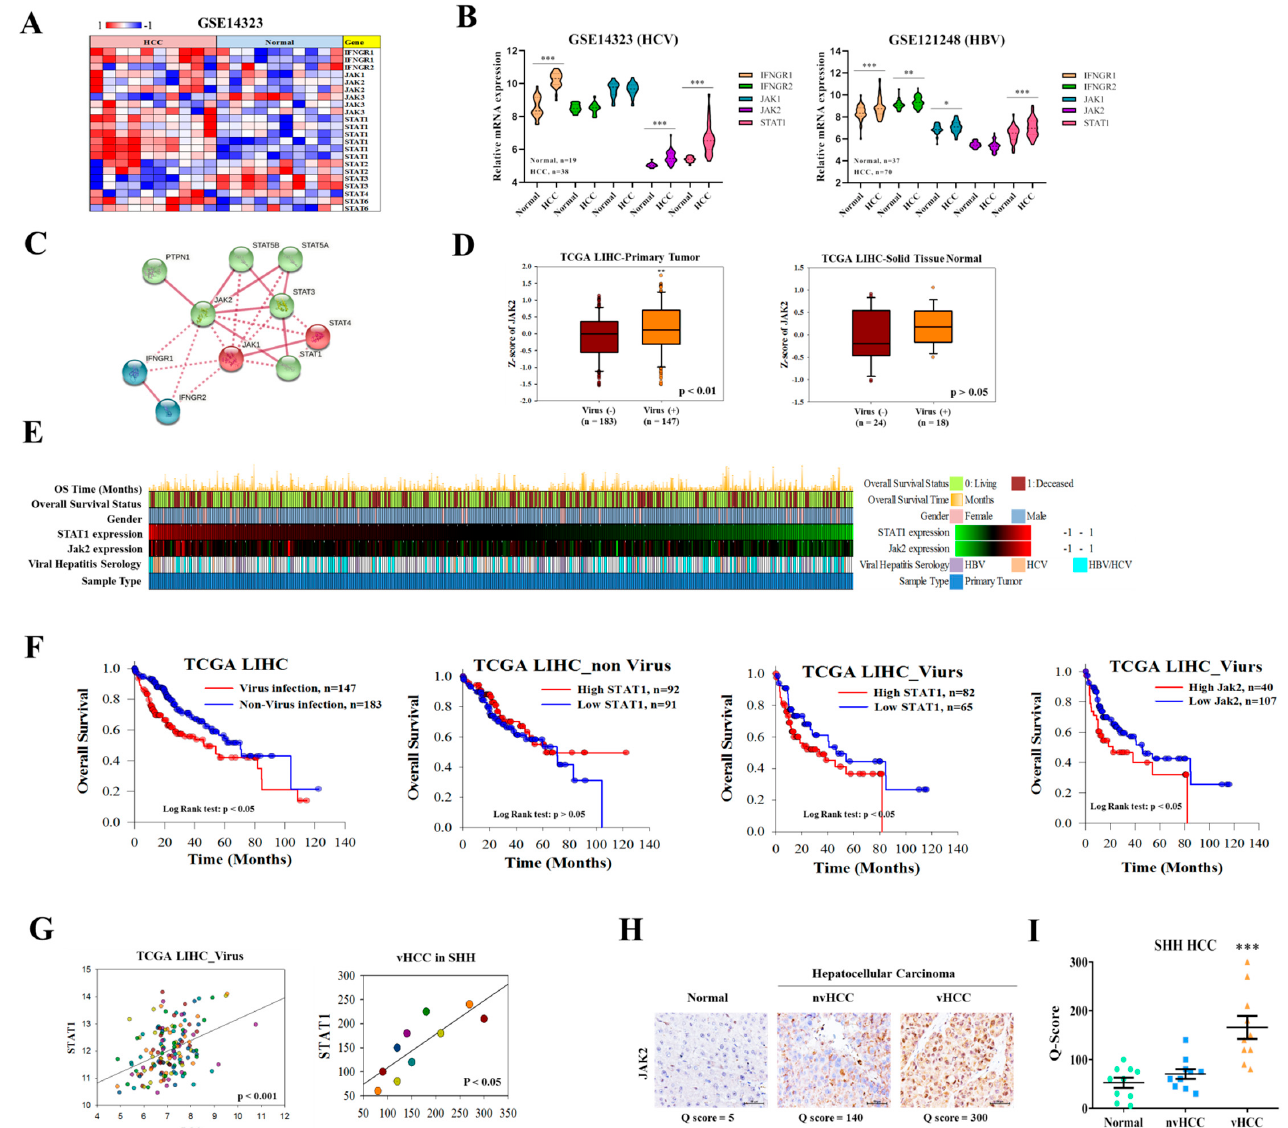
Figure 1. IFNGR, JAK, and STAT expression in vHCC, nvHCC, and normal liver samples. ( A ) Heatmap of 10 sample NT pairs, including both normal liver and vHCC in GSE14323 with top highly expressed genes detected by different probes. ( B ) Violin plot showed differential expression of IFNGR1, IFNGR2, Jak1, Jak2, and STAT1 in normal liver and vHCC samples from GSE14323 and GSE121248. ( C ) Schematic representation of the interaction of the IFNGR-JAK-STAT signaling proteins with the STRING analysis. ( D ) Expression of JAK2 in nvHCC and vHCC samples were analyzed from TCGA LIHC with 95% CI. ( E ) Heatmap of different Hepatitis Virus-Associated Liver cancer samples. The TCGA LIHC samples information containing overall survival status, gender, JAK2 expression, viral hepatitis serology, and sample type are shown on the left, and color block meaning is shown at the right (n = 325). ( F ) Overall survival of patients with vHCC was significantly lower than that of patients with nvHCC ( p < 0.01, KM survival curve). ( G ) Analysis of the relationship between JAK2 and STAT1 expression in vHCC. ( H ) IHC image of Jak2 expression in normal liver, nvHCC, and vHCC samples (n = 30) from the Taipei Medical University Shuang-Ho Hospital HCC cancer cohort. ( I ) Q-score of JAK2 expression in Shuang Ho Hospital patients with Hepatocellular Carcinoma. * p < 0.05; ** p < 0.01; *** p < 0.001. Scale bar: 50 µ m. HBV: Hepatitis B virus; HCV: Hepatitis C